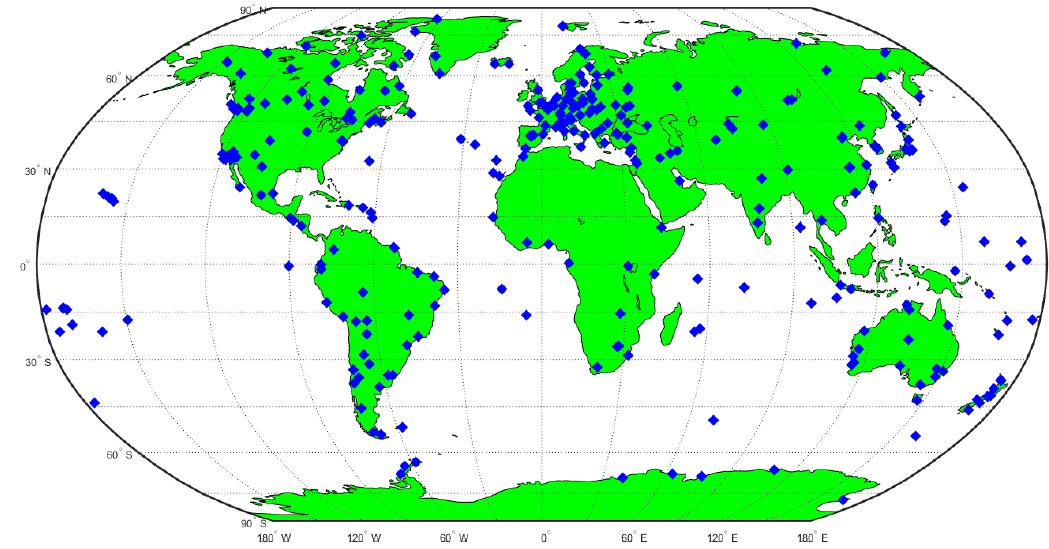
Figure 1. Geographical distribution of the selected 375 global IGS tracking stations in September 2017.